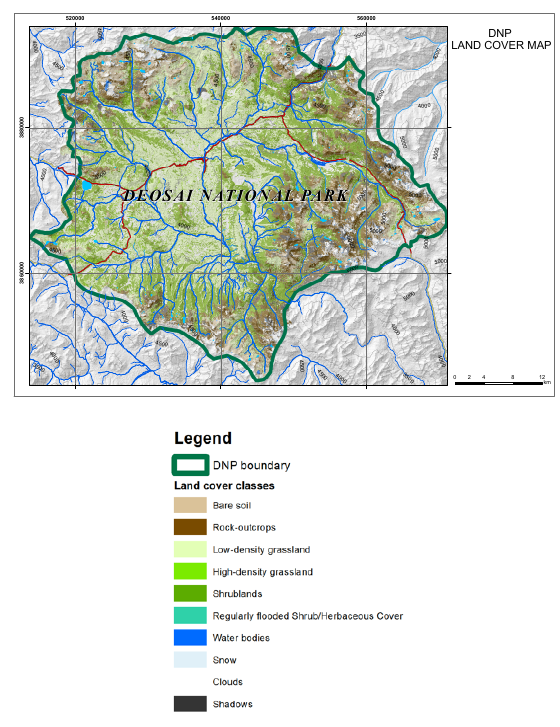
Figure 6. Land cover map and